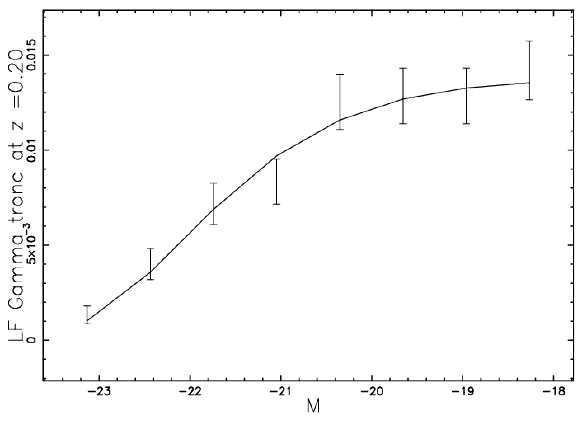
0.2 and ∆ z 0.05. The (cid:16) (cid:16)